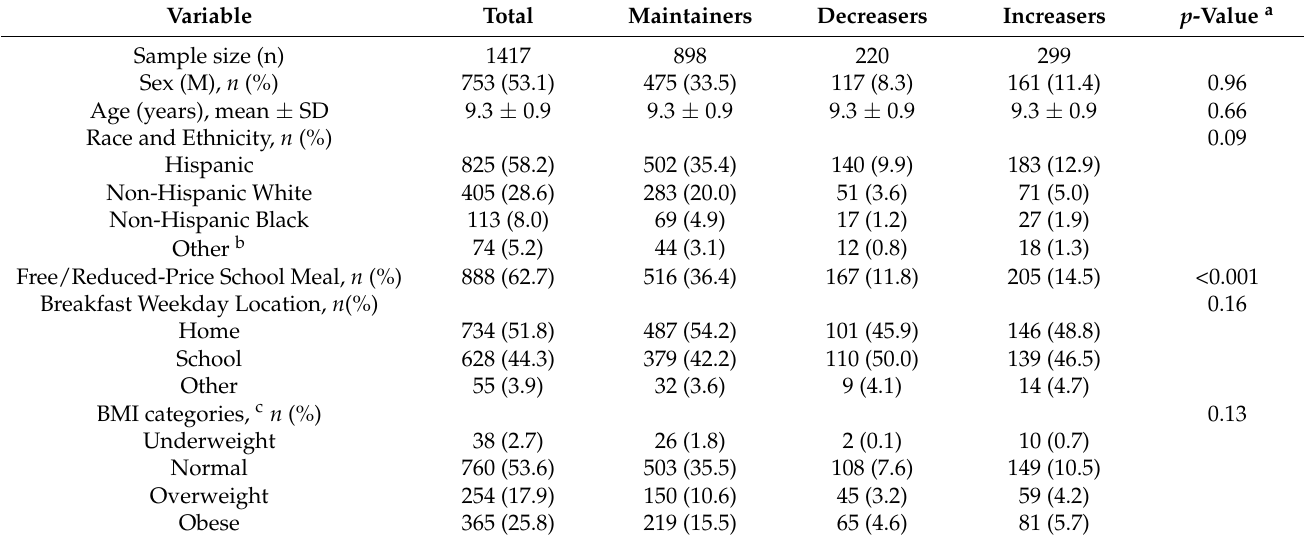
Table 2. Sociodemographic and physical characteristics of participants by breakfast consumption